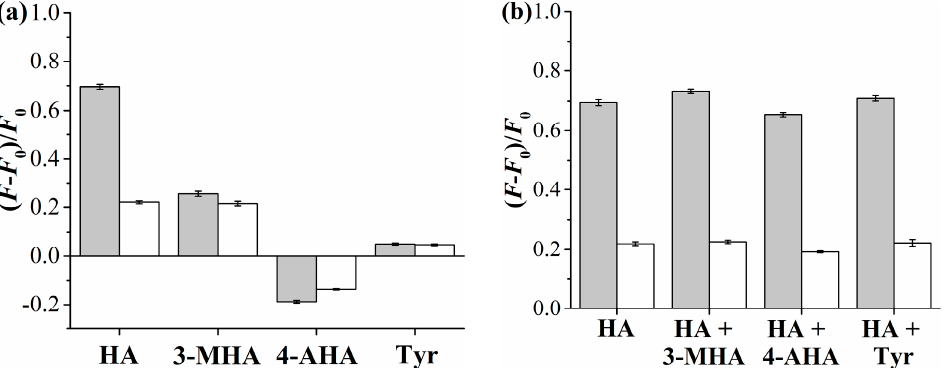
Figure 5. Fluorescence enhancement of the hydrophilic fluorescent hollow HA-MIP (filled column)/CP (open column) upon exposure to a HA, 3-MHA, 4-AHA, or Tyr solution ( C HA, 3-MHA, 4-AHA, or Tyr = 20 μ M) ( a ) or to a HA solution (20 μ M) in the presence of 40 μ M of 3-MHA, 4-AHA, or Tyr ( b ) in the artificial urine at 25 °C for 2 h (hollow MIP/CP concentration: 0.25 mg/mL; their concentration was calculated by using the weights of their solid counterparts before etching).